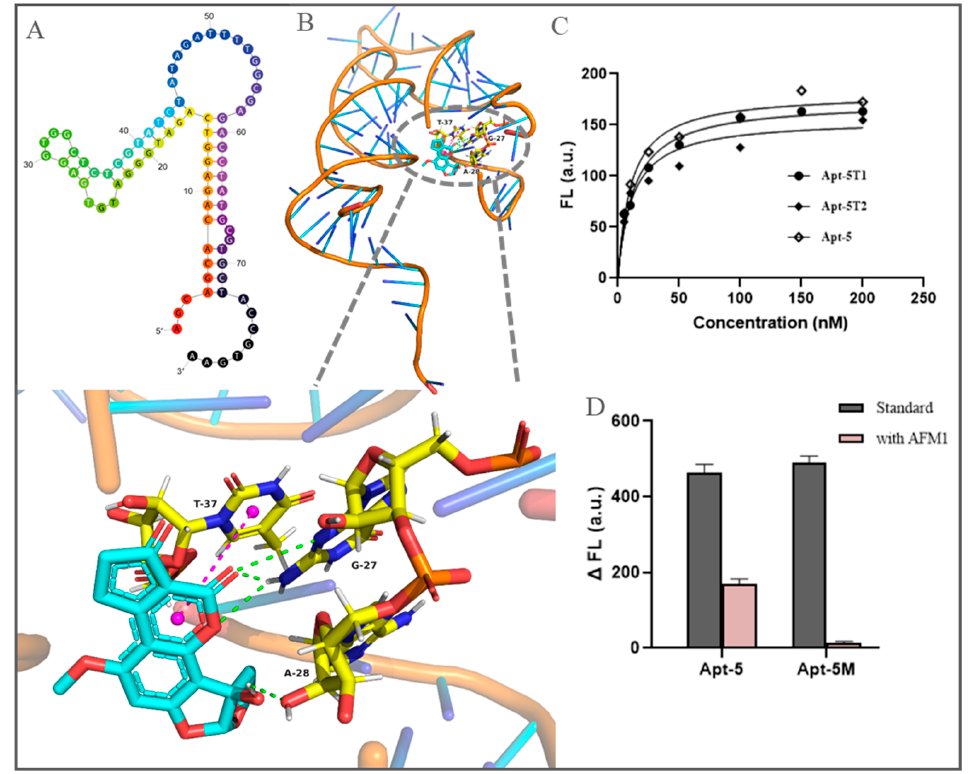
Figure 3. ( A ) Molecular docking results depicting interaction between aptamer Apt-5 and AFM1 (the green dashed line represents hydrogen bonding, and the pink dashed line represents hydro- phobic interaction). ( B ) Secondary structure of Apt-5. ( C ) Nonlinear fitting curves of truncated se- quences Apt-5T1, Apt-5T2, and full-length Apt-5. ( D ) Fluorescence recovery of Apt-5 and mutant sequence Apt-5M.